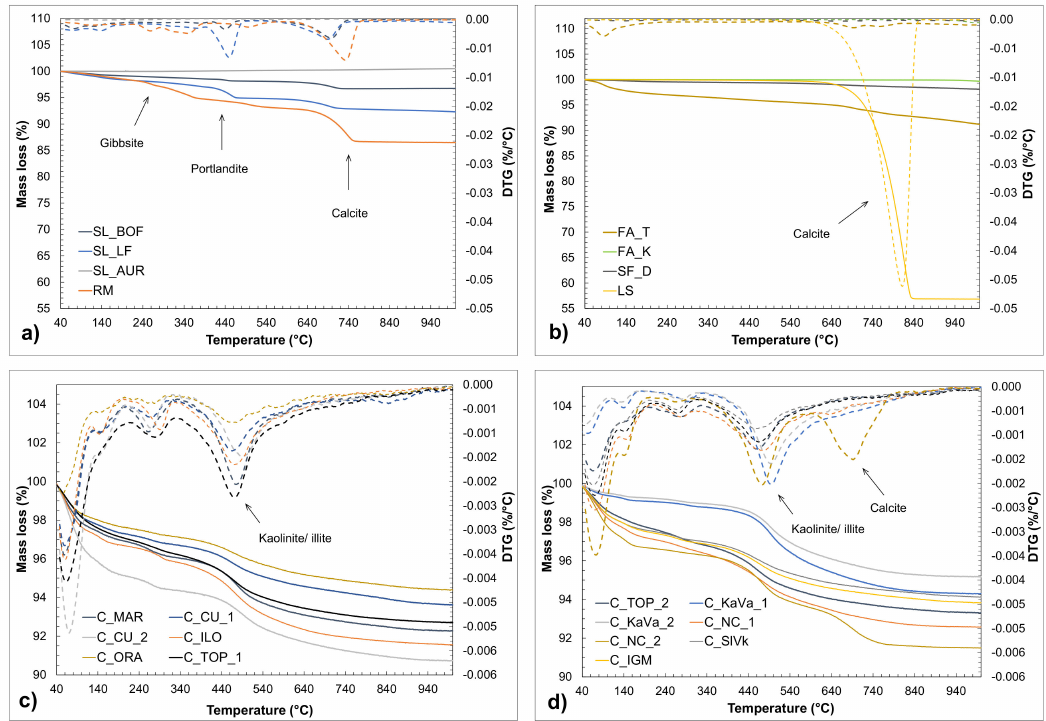
Figure 5. Mass loss and derivative of mass loss (DTG) of raw materials obtained by heating the samples from 40 ◦ C to 1000 ◦ C, with indicated main phases observed: ( a ) slags, iron silicate fines and red mud ( b ) fly ashes, silica fume and limestone, ( c , d )